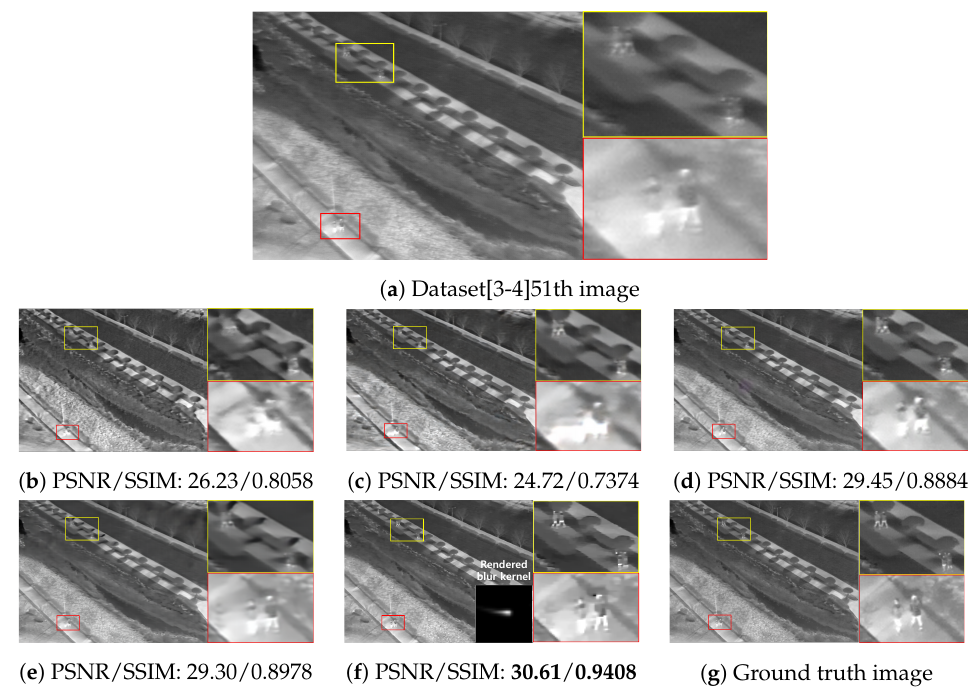
Figure 13. Qualitative comparison of deblurring results on the SBTI dataset [3-4]51th. ( a ) Synthetic blurry thermal images, ( b ) SRN [33] ( c ) SIUN [36], ( d ) DeblurGAN.v2 [35], ( e ) CDVD [34], ( f )